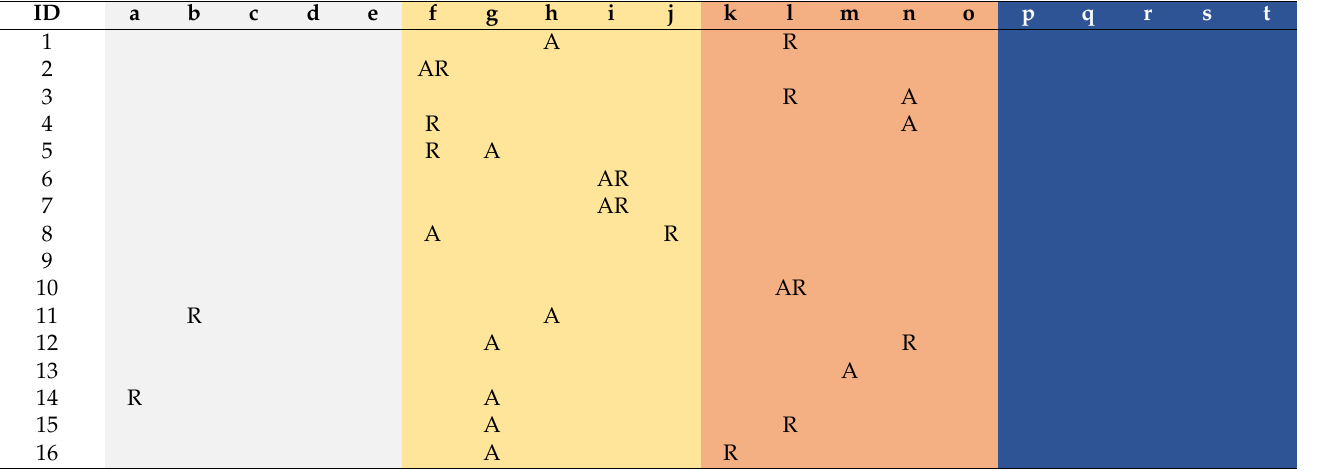
Table 7. The most accurate methods used for active (A) and reactive (R) power calculation per building ID.